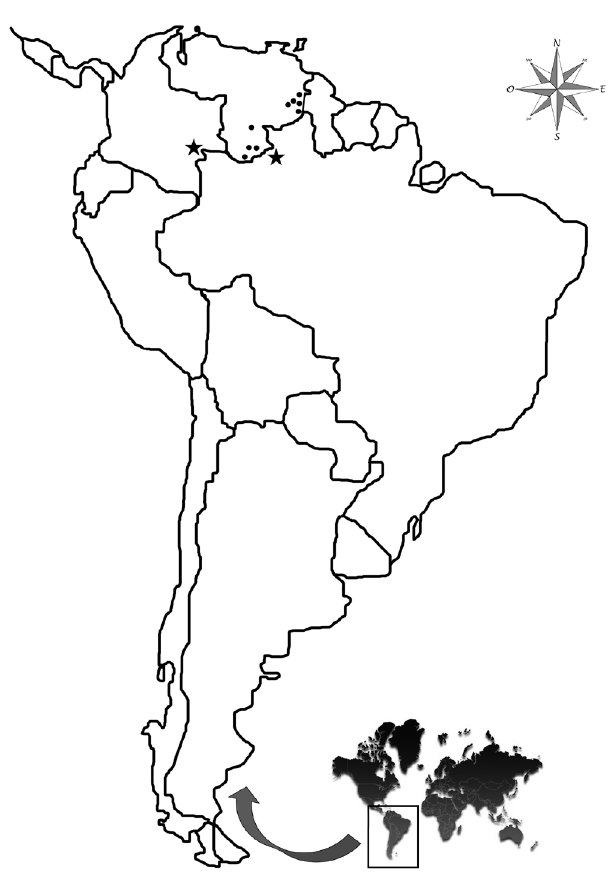
Cephalocarpus confertus. Distribution of Circles shows the distribution in Venezuela and stars shows expanded distribution in Brazil and